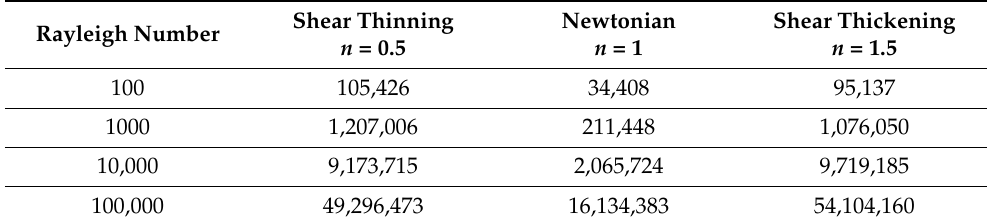
Table 5. Variation in kinetic energy against ( n ) and ( Ra ) at X = 0.5. Rayleigh Number